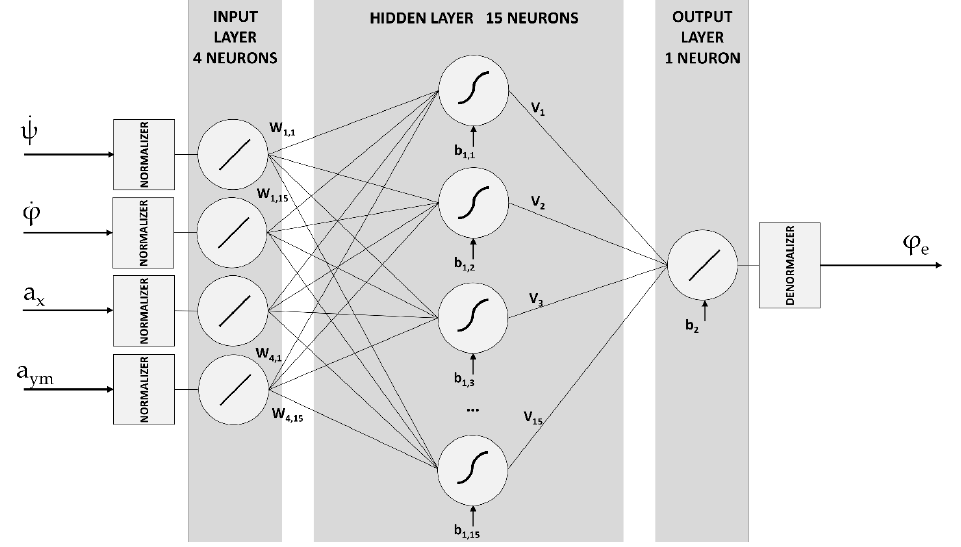
Figure 3. Artificial neural network architecture.